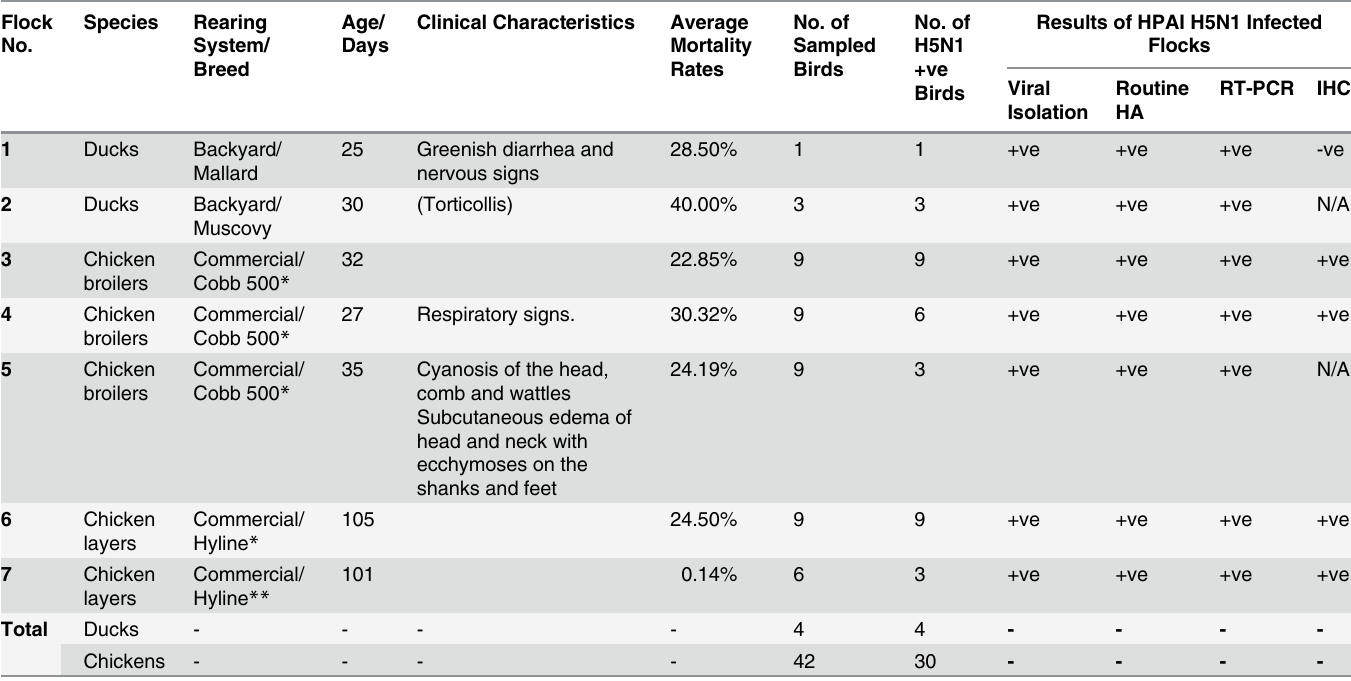
Table 2. The Outbreaks of HPAIV H5N1 in the Egyptian Commercial Poultry Farms and the Virus Identification. Flock